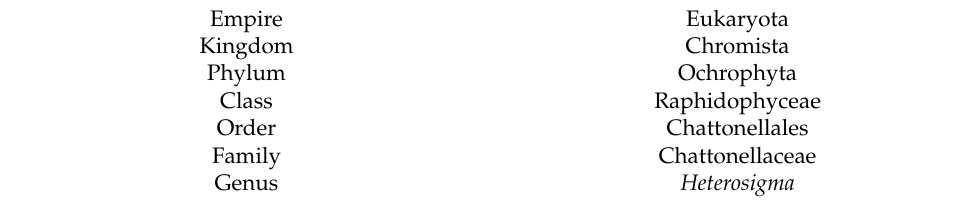
Table 1. Hetrosigma classification [21].